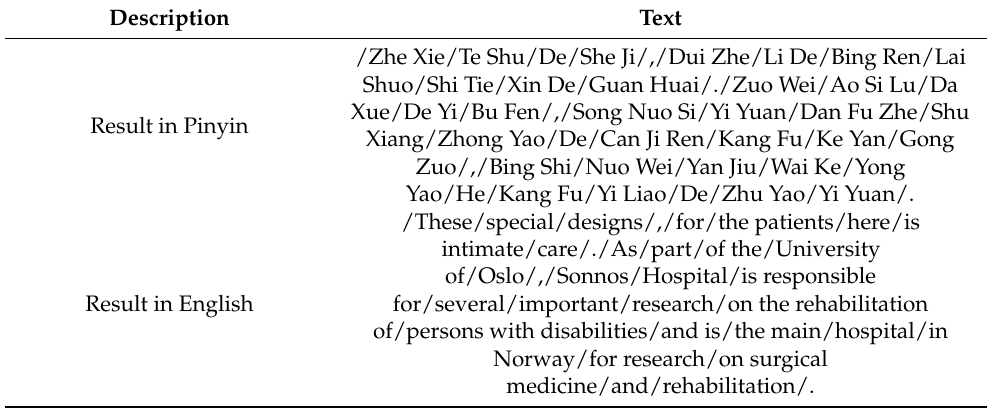
Table 4. Result display of the HCRF algorithm for general text segmentation. Description